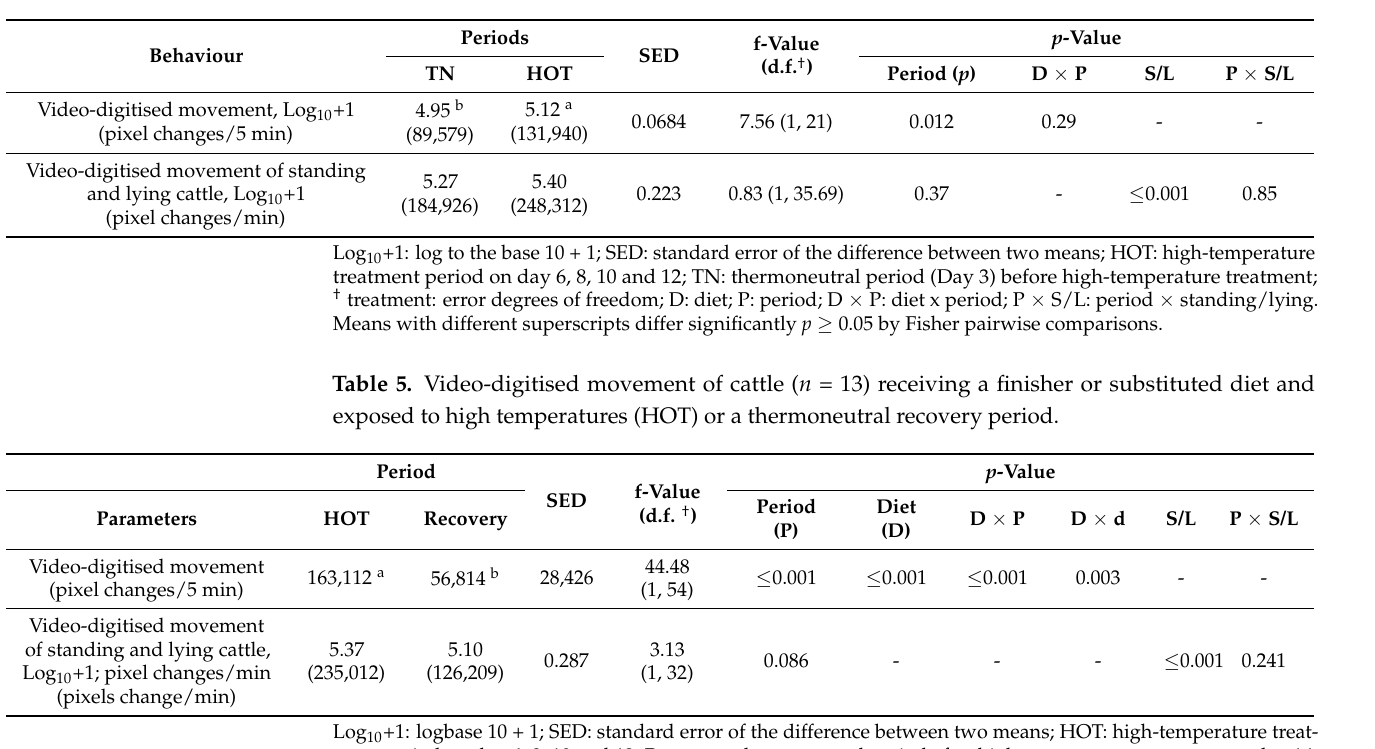
Table 4. Video-digitised movement of cattle ( n = 13) receiving a finisher or substituted diet and exposed to high temperatures (HOT) or initial thermoneutral period (TN).